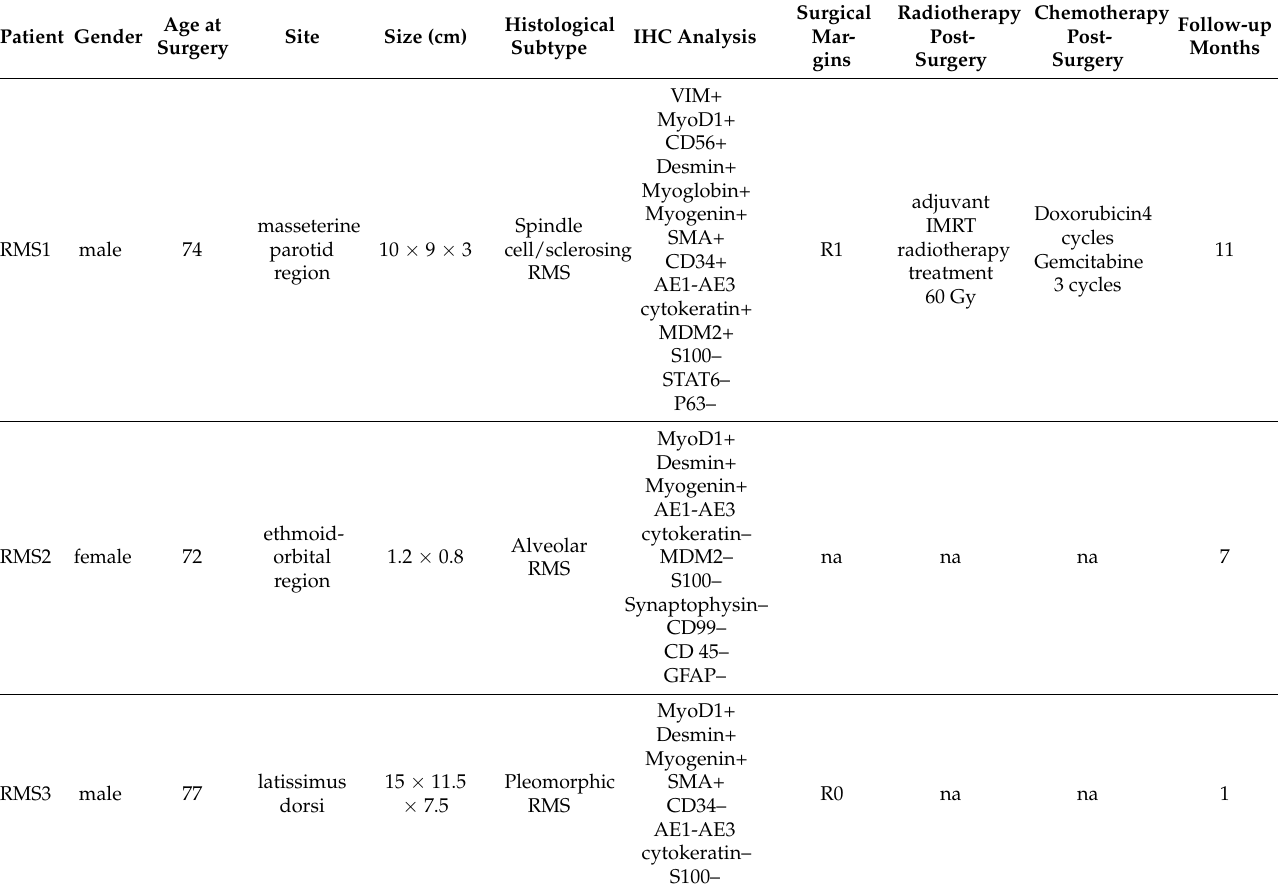
Table 1. Clinicopathological characteristics of enrolled